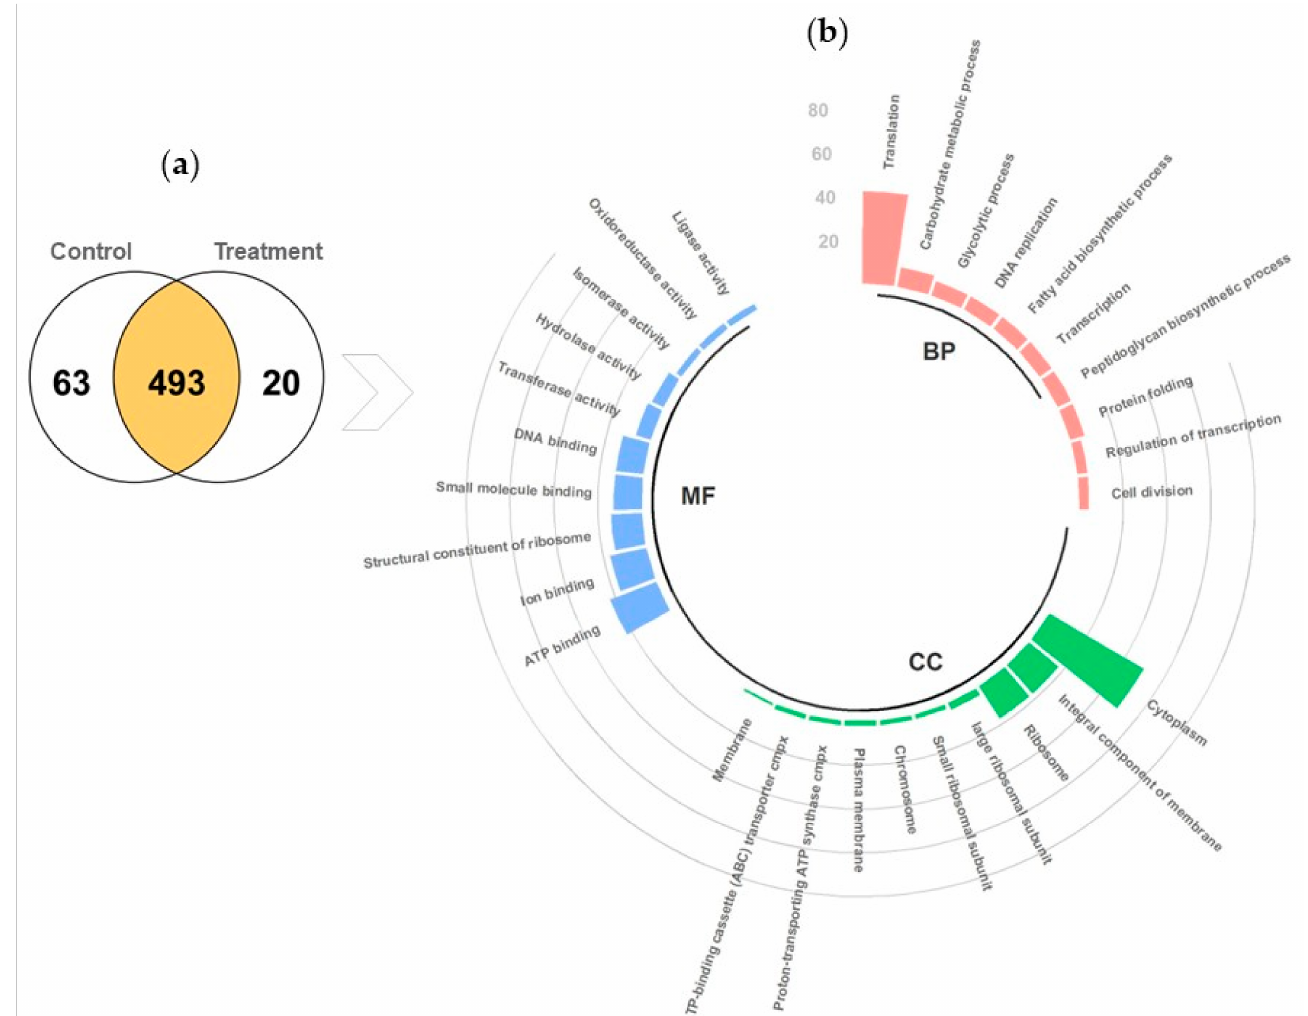
Figure 3. ( a ) Venn diagram and ( b ) circular bar plot: gene ontology classification for global proteins. The results are summarized in three main categories: biological process ( BP ), cellular component ( CC ), and molecular function ( MF